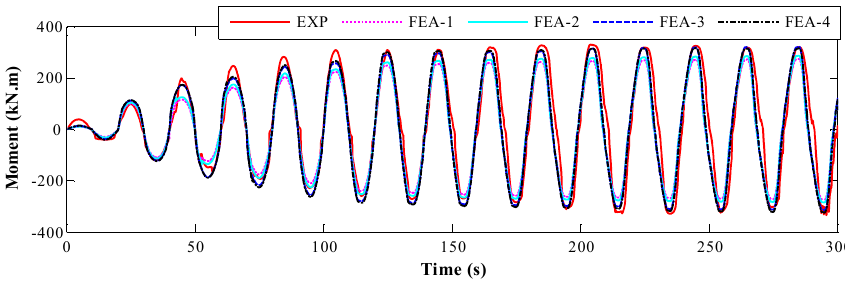
Figure 11. Time-history of the cross-section moment for experimental and analytical results.